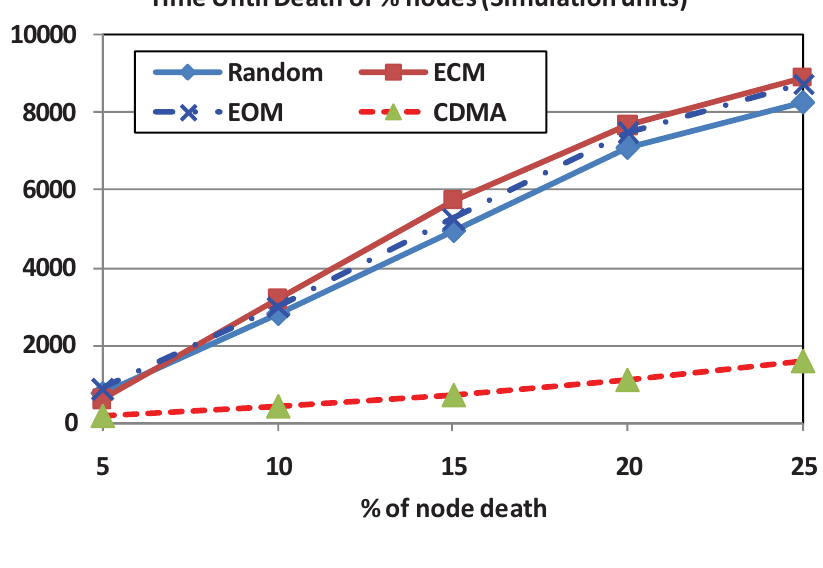
Figure 7. Average network lifetime for both OFDMA and CDMA. BW = 24 KHz; N = 100; transmission rate = 2 Kbps; Number of subcarriers =